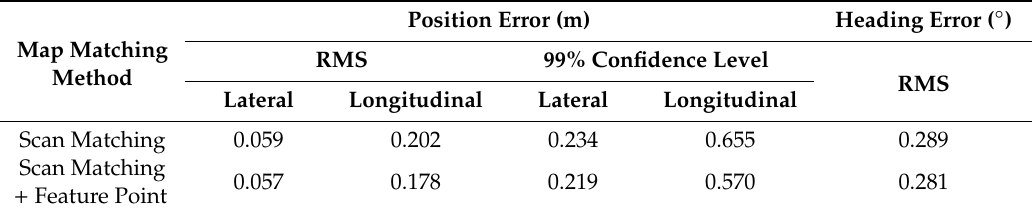
Table 5. Comparison of localization performance (map matching method).